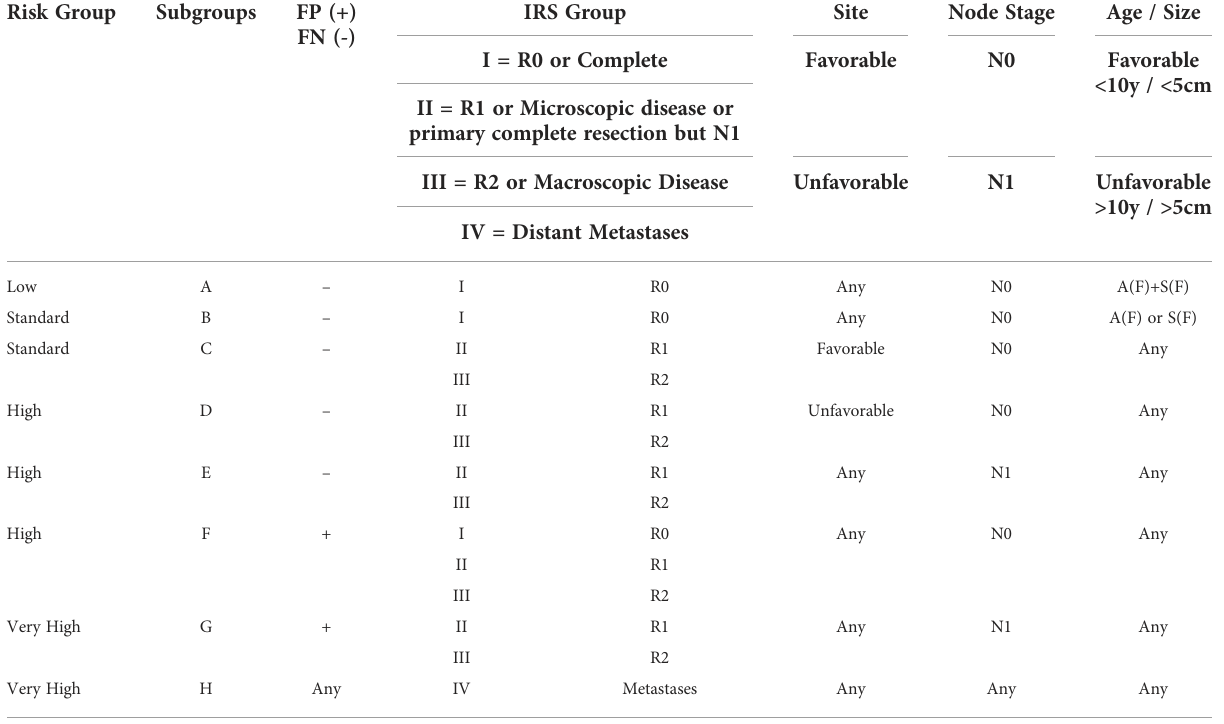
TABLE 3 European Paediatric Soft Tissue Sarcoma Study Group staging of